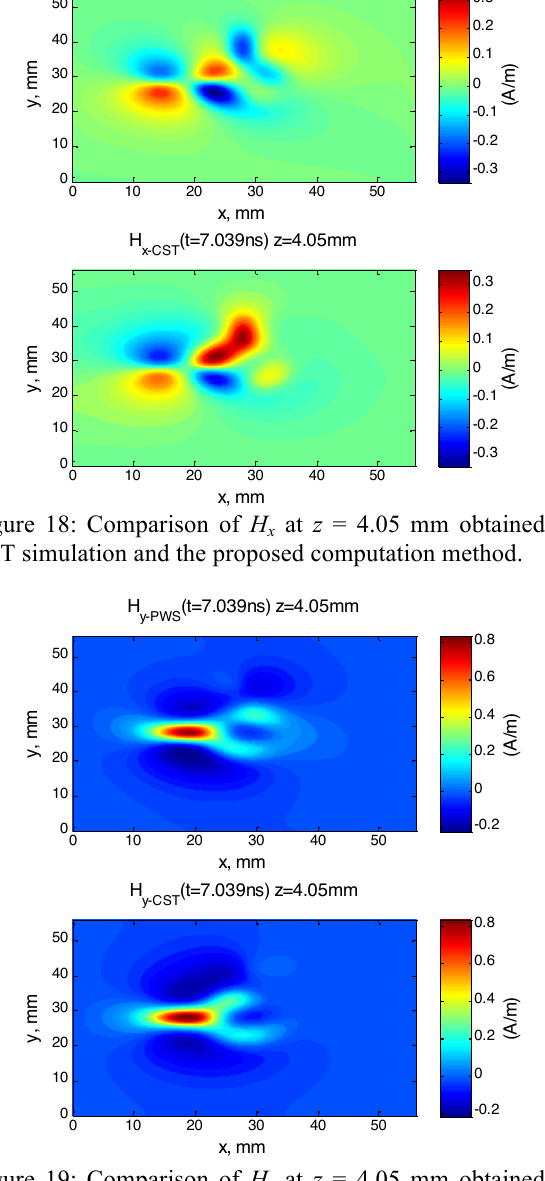
at z = 4.05 mm obtained by y